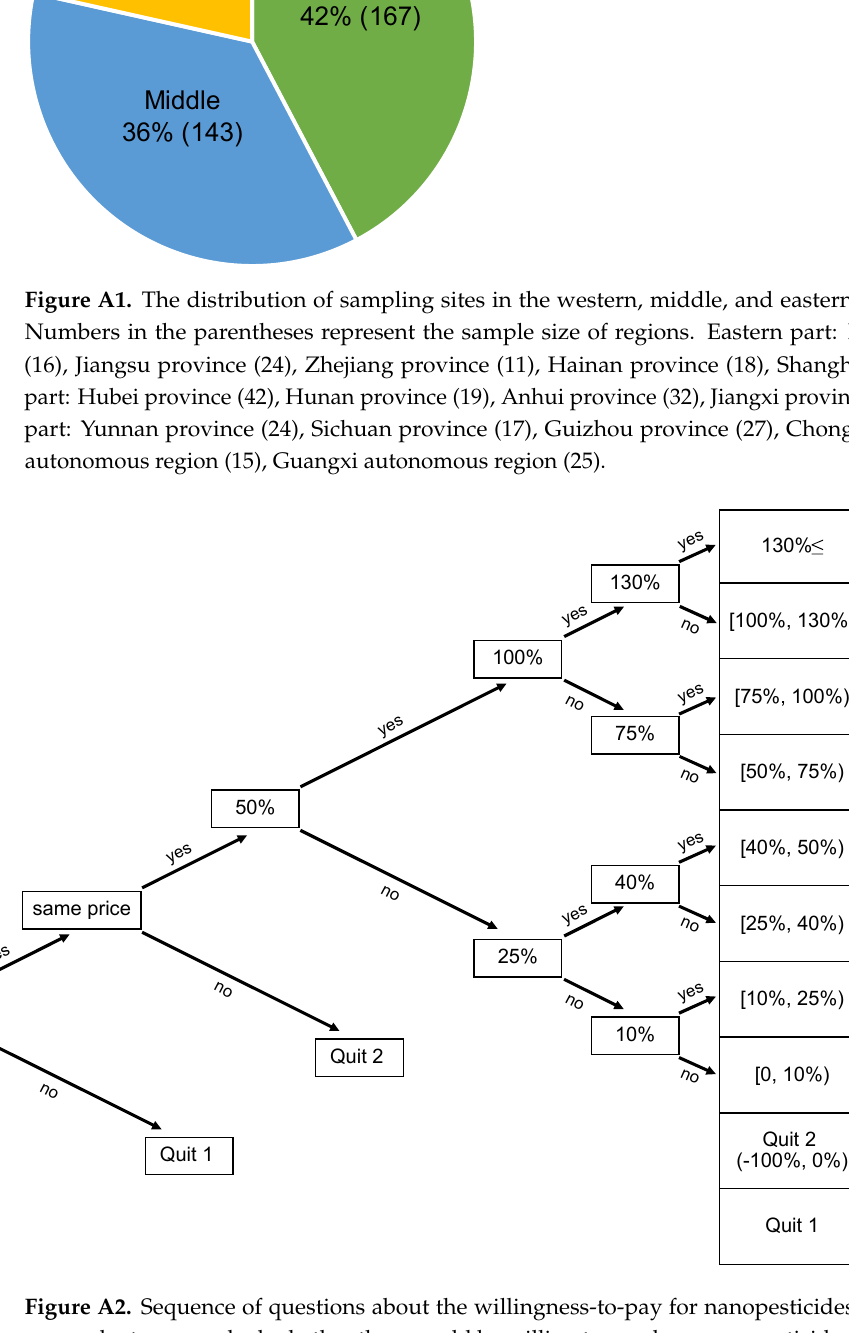
Figure A2. Sequence of questions about the willingness-to-pay for nanopesticides. At each node, respondents were asked whether they would be willing to purchase nanopesticides if the price was lower, the same as, or X% higher than conventional pesticides. The right column shows bounds on the percentages that respondents were willing to pay for nanopesticides above that for conventional pesticides.